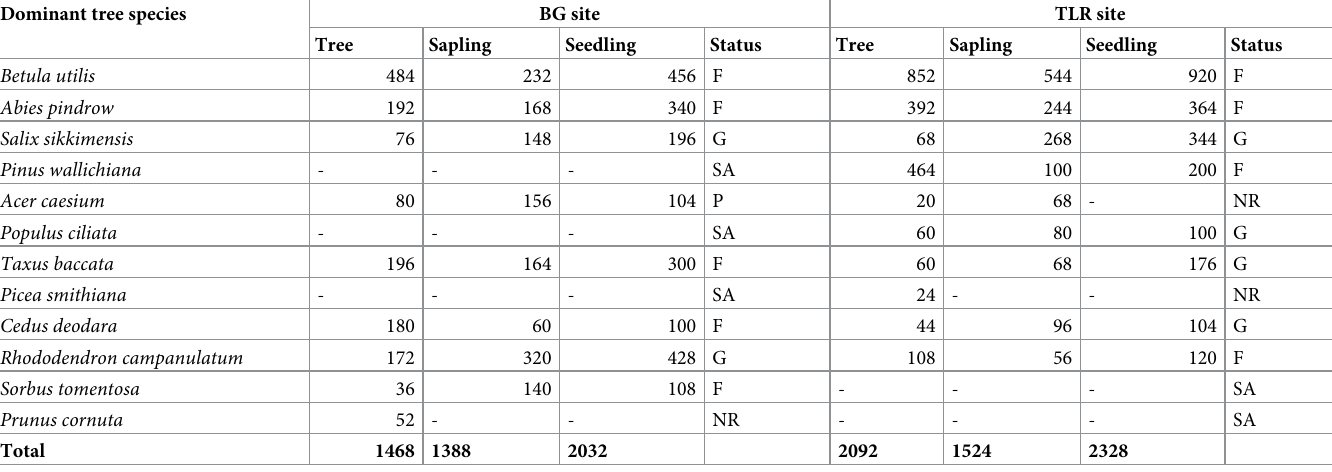
Table 5. Regeneration status of trees species around BG and TLR sites, Nanda Devi Biosphere Reserve, Western Himalaya. Dominant tree species